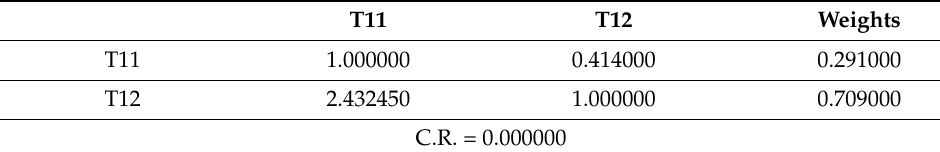
Table 8. Aggregated pair-wise comparison matrix at level 2 for Compromise Level.